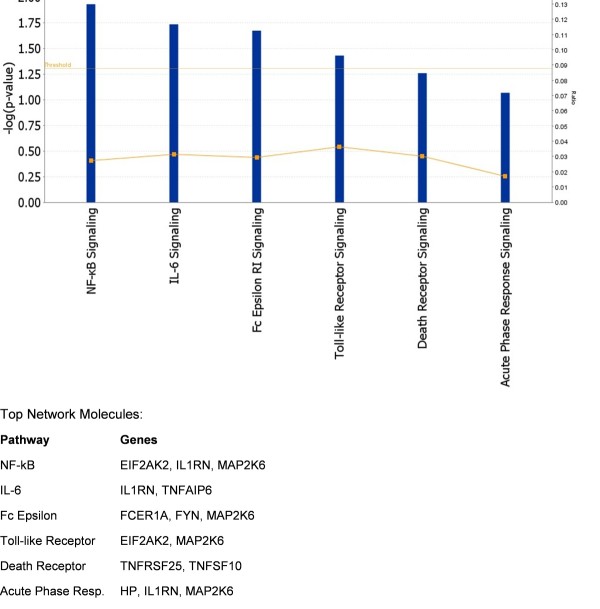
Ingenuity pathways analysis of 104 probes with false discovery rate-adjusted P values of less than 0.1. The analysis compares 20 twins affected with systemic autoimmune disease and 40 unrelated, matched controls. P values (blue bars) describing the confidence of the association of the data set with a given pathway are shown on the left vertical axis (-log(P value)). The cutoff threshold value (defined as P = 0.05) is also shown (horizontal yellow line). The ratio of the number of genes from the data set that map to a given pathway divided by the total number of molecules that comprise the pathway (orange line connecting blue bars) is shown on the right vertical axis. IL-6, interleukin-6; NF-κB, nuclear factor-kappa-B.